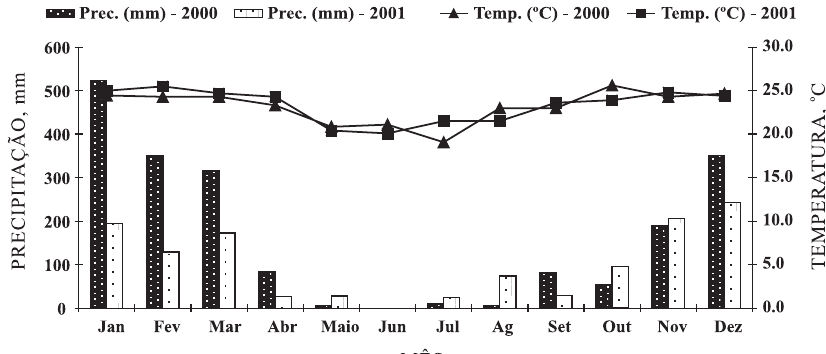
Figura 1. Temperatura e precipitação pluvial média obtida na Estação climatológica de Uberaba INMET/ EPAMIG em 2000 e